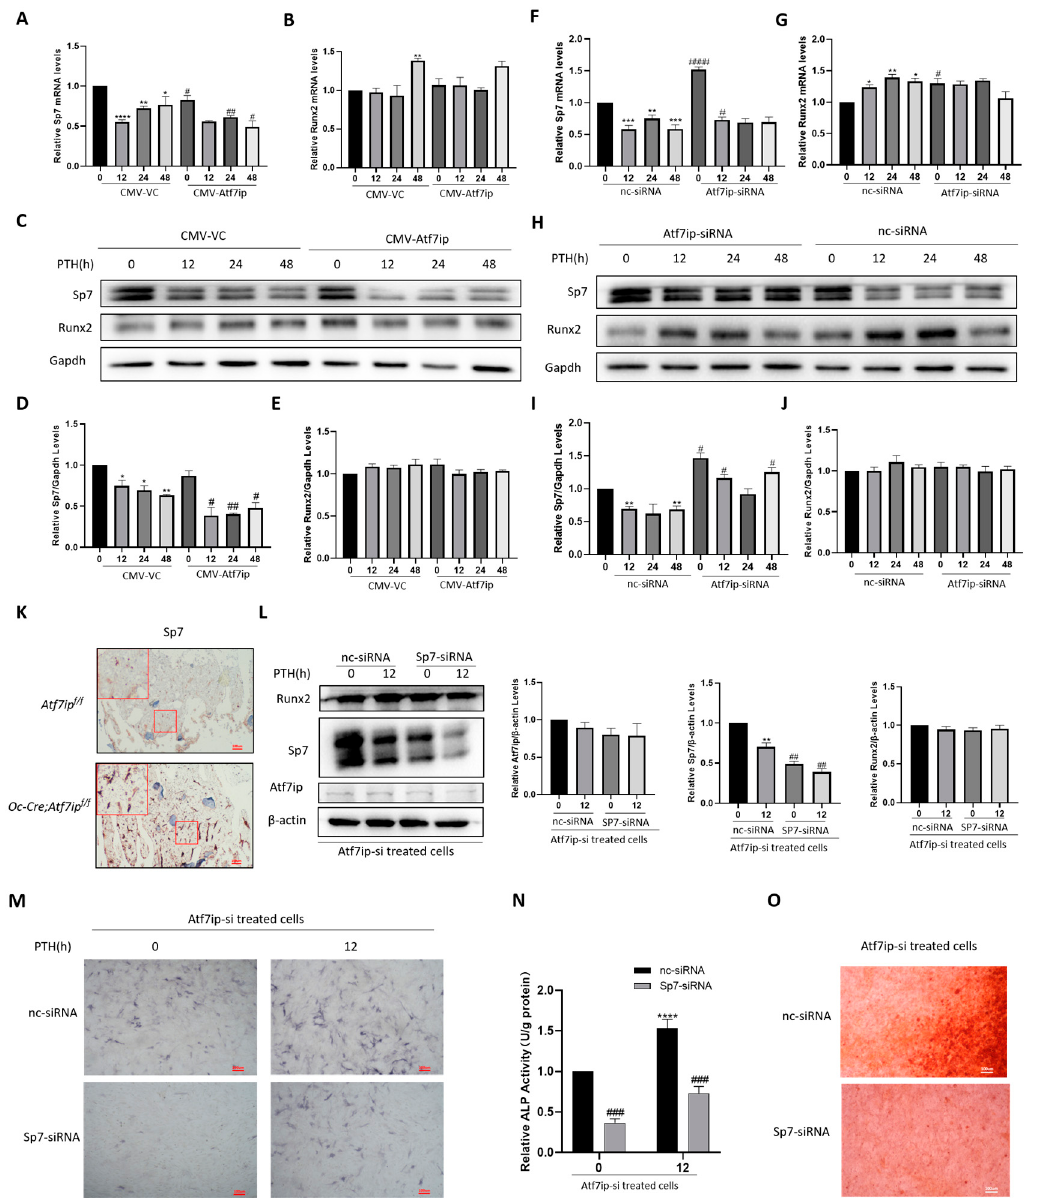
Figure 6. Inhibition of Sp7 attenuates Atf7ip–siRNA-promoting osteoblast differentiation. MC3T3- E1 cells were first transfected with CMV-Atf7ip ( A – E ) or Atf7ip-siRNA ( F – J ) and their respective controls, and then treated with 500 ng/mL PTH for the indicated time. The mRNA and protein levels of Runx2 and Sp7 were analyzed by q-RT-PCR and Western blot, respectively. ( K ) Immunohisto- chemistry of Sp7 in the femoral section of Ocn-Cre Atf7ip fl/fl and Atf7ip fl/fl mice. The high magnifi- cation for representative images is shown. Selected sections magnified 10-fold. Scale bar = 100 µ m ( L – O ) MC3T3-E1 cells were treated with Atf7ip-siRNA for 24 h, followed by transient nc-siRNA and Sp7-siRNA for 24 h and, finally, PTH for 12 h. ( L ) Western blot of the protein expressions of Runx2, Sp7, and Atf7ip. ALP staining ( M ), ALP activity assays ( N ), and ARS staining ( O ) were used to detect the osteoblast differentiation status. For WB, Gapdh was used as the loading control. The experiments were repeated at least three times. For ALP staining and ARS staining, scale bar = 100 µ m. Data are expressed as mean ± SD ( n = 3). The significance was measured by one-way ANOVA, * p < 0.05, ** p < 0.01, *** p < 0.001, **** p < 0.0001, PTH group vs. saline group; # p < 0.05, ## p < 0.01, ### p < 0.001, #### p < 0.0001. overexpression or interference vs. vector control or nc-siRNA